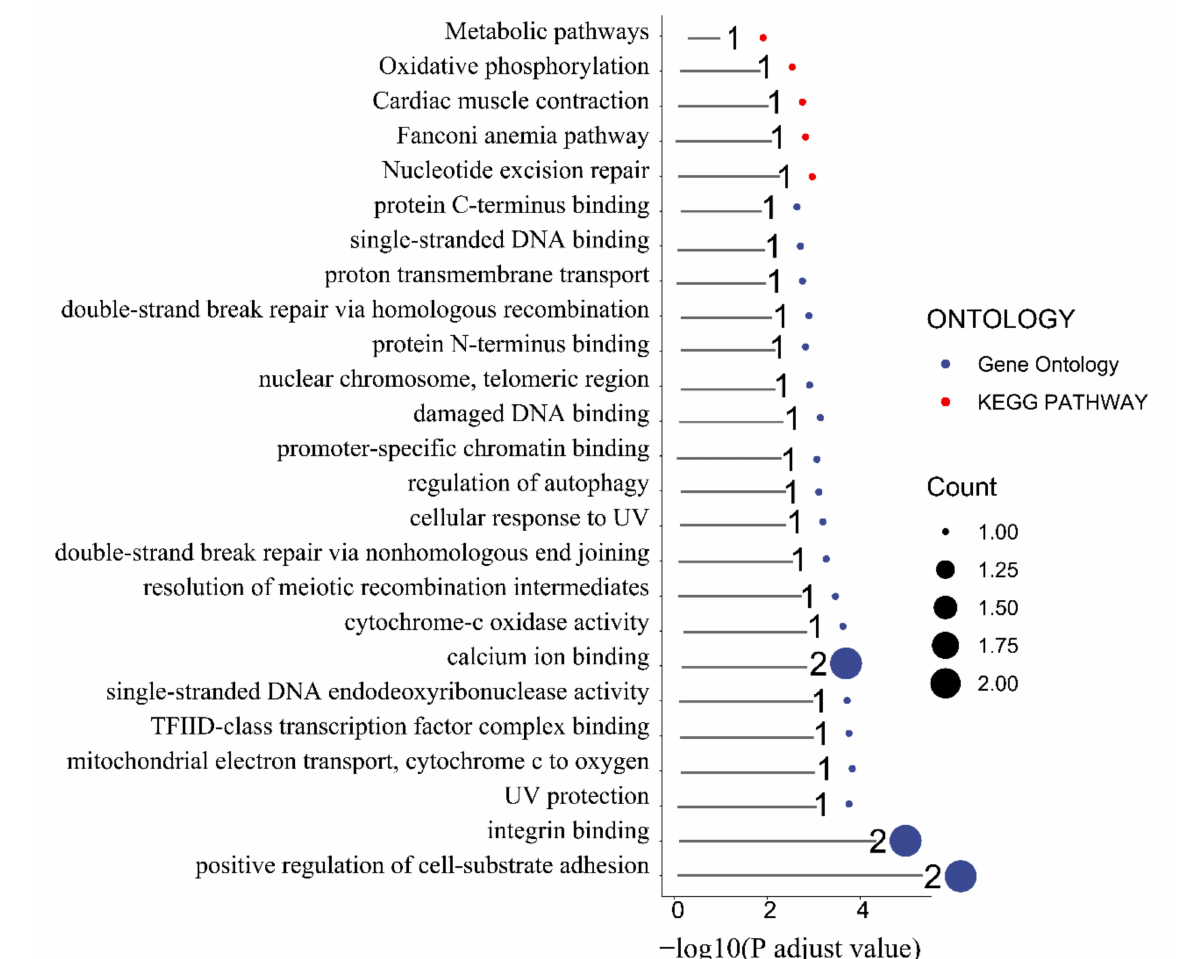
Figure 5. Functional enrichment analysis of the feed conversion ratio. Red and blue colored ribbons represent GO terms and KEGG pathways,